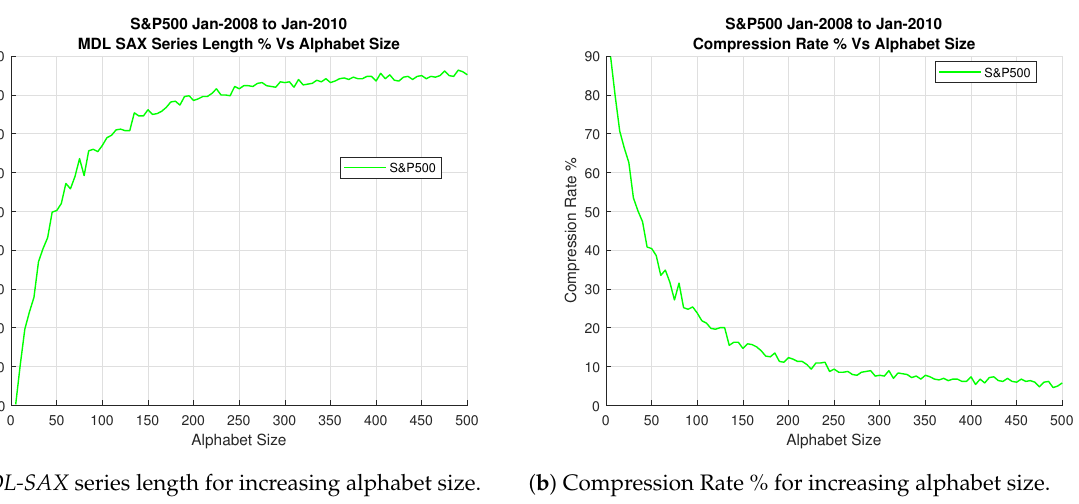
Figure 7. Effect of MDL application to a SAX S&P500 series from January 2008 to January 2010. Accordingly, as the alphabet size used to create the SAX representation of the S&P500 series increases, the length of the resulting MDL-SAX series also increases ( a ) while the compression rate is reduced ( b ). A large alphabet size range is utilised here to illustrate the stability of the compression rate at higher alphabet